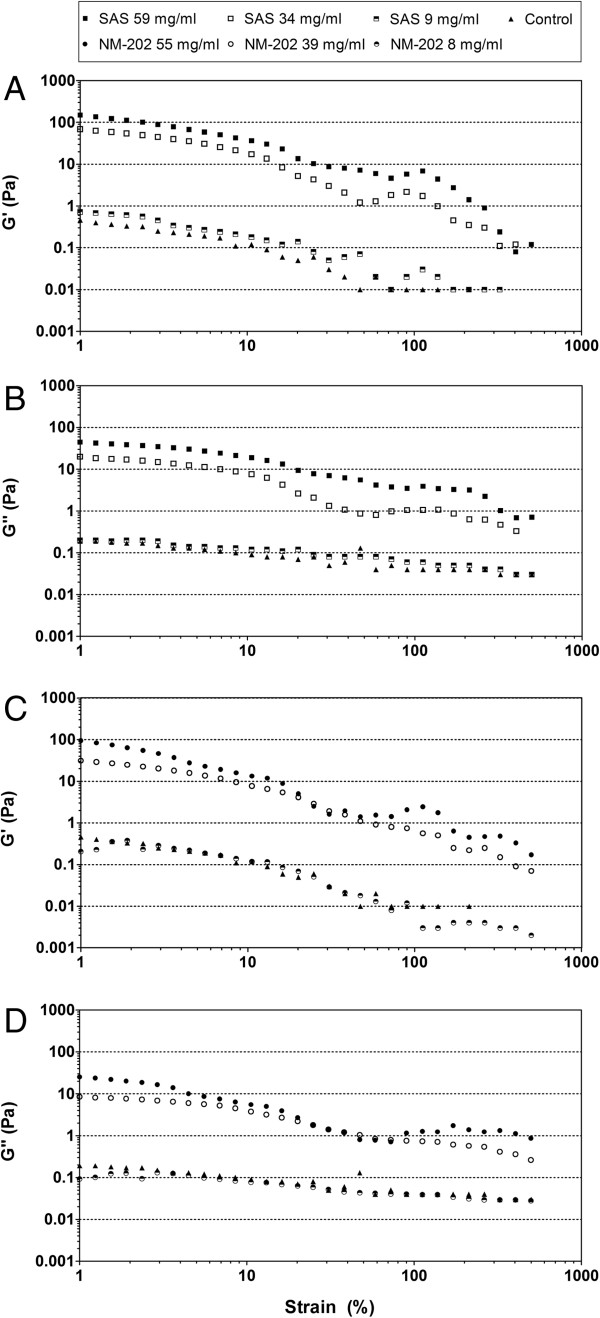
Visco-elastic behavior of SAS and NM-202 in the feed mixture after in vitro digestion. Higher storage moduli (G’) of (A) SAS and (C) NM-202 than loss moduli (G”) of (B) SAS and (D) NM-202 (as a function of the strain) indicate increasing gel-like properties, with increasing SiO2 concentrations.